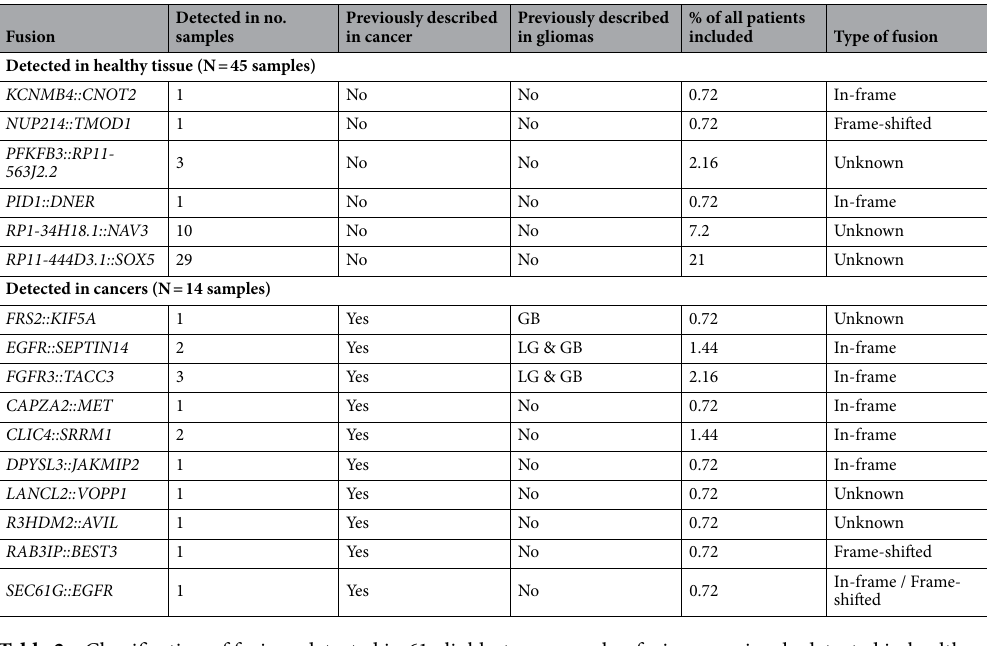
Table 2. Classification of fusions detected in 61 glioblastoma samples: fusions previously detected in healthy tissue (N = 6) or in cancers (N = 10). LG low-grade glioma, GB glioblastoma.